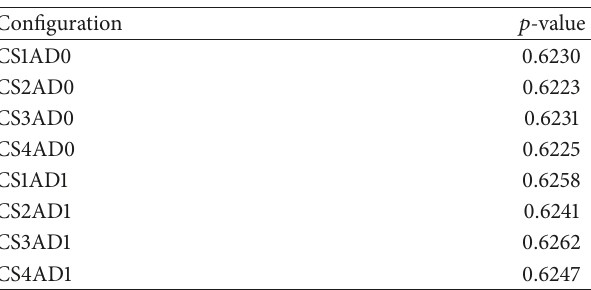
Table 6: Summary of normality test.